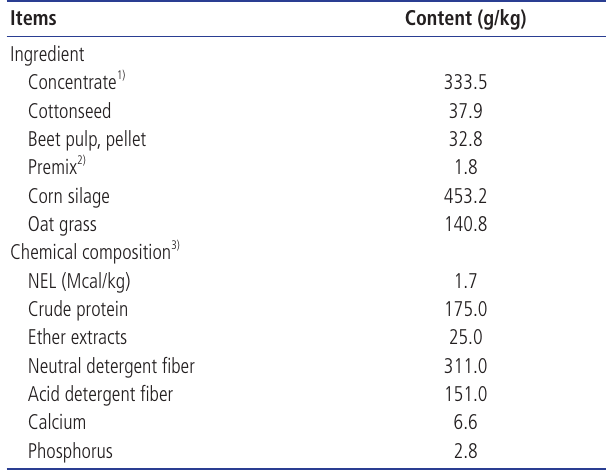
Table 1. Ingredient and chemical composition of basal